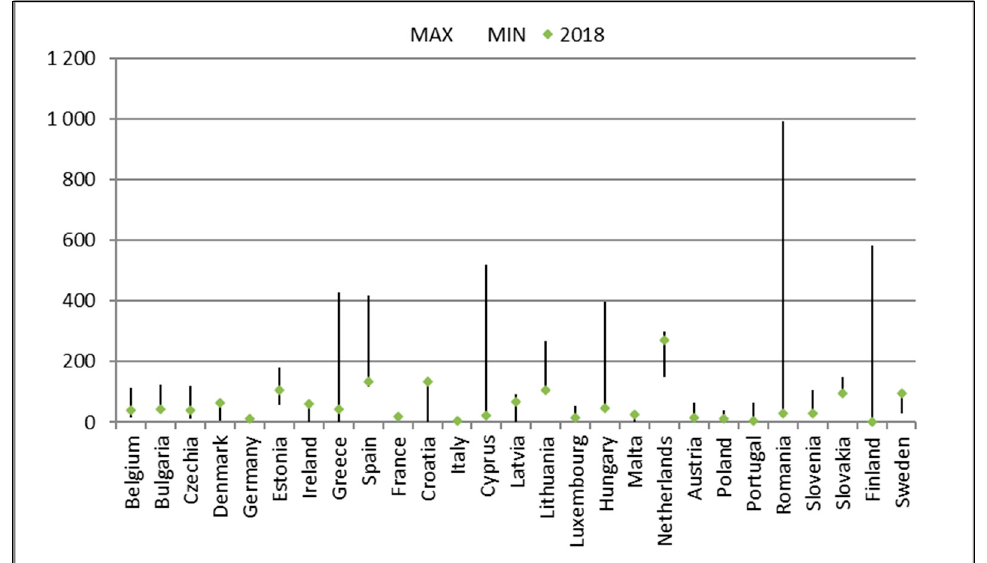
Figure 4. Generation of waste in agriculture, per capita (2004–2018).